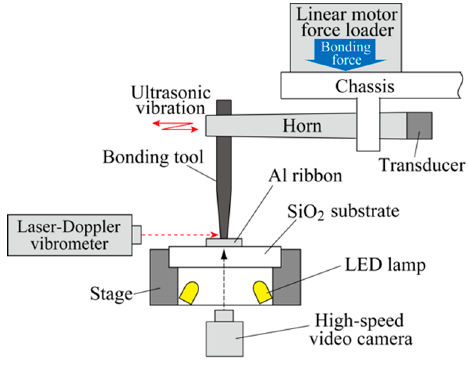
Figure 1. Schematic illustration of ultrasonic bonding apparatus and in-situ observation system.